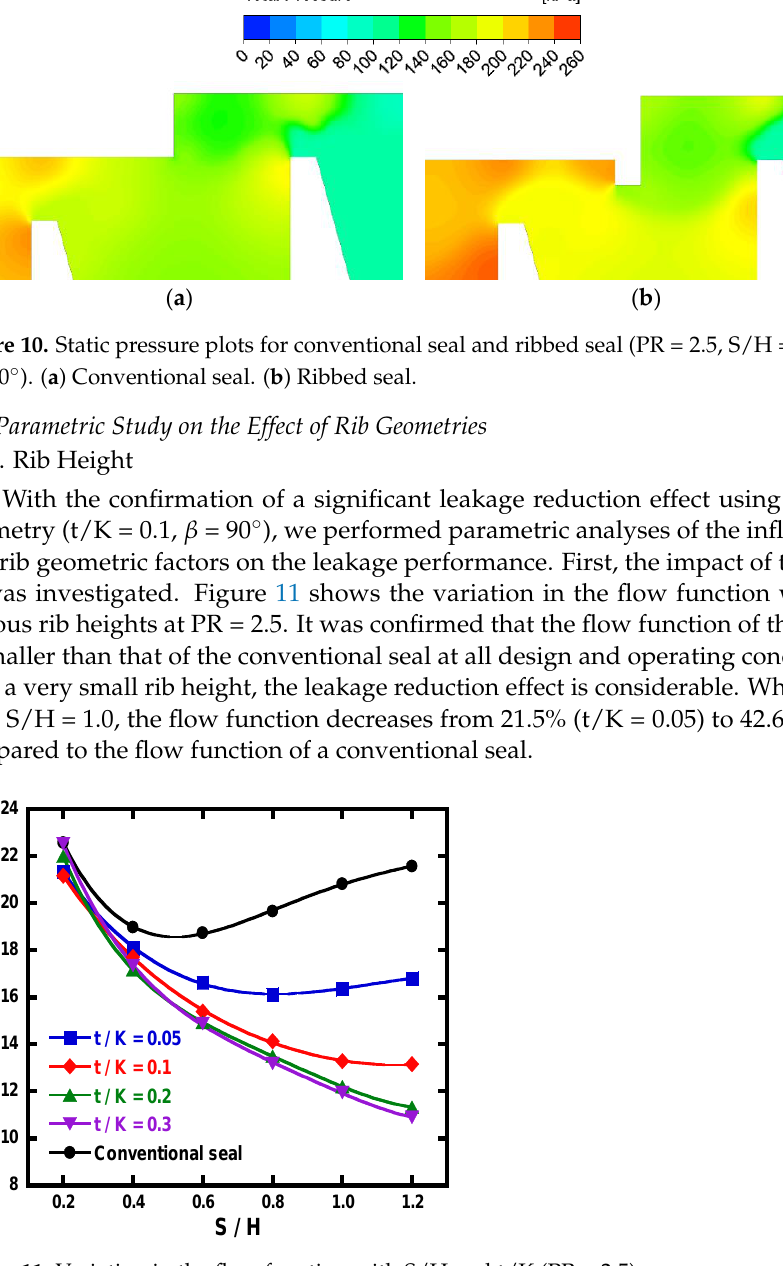
Figure 9. Total pressure plots for conventional seal and ribbed seal (PR = 2.5, S/H = 1.0, t/K = 0.1, β = 90°). ( a ) Conventional seal. ( b ) Ribbed seal.